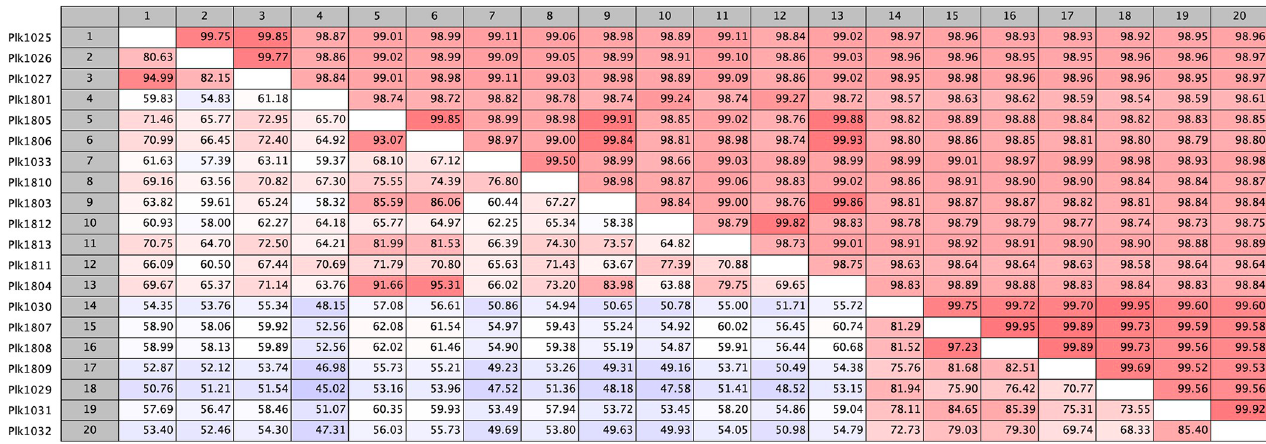
Fig 1. Relatedness of whole genome alignment of 20 P . agardhii isolates from Sandusky Bay, Lake Erie. The top of the matrix is the average nucleotide identity (ANI) common between two isolates. The bottom of the matrix is the alignment percentage (AP) common between two isolates. The lowest AP value suggests a common genome core of